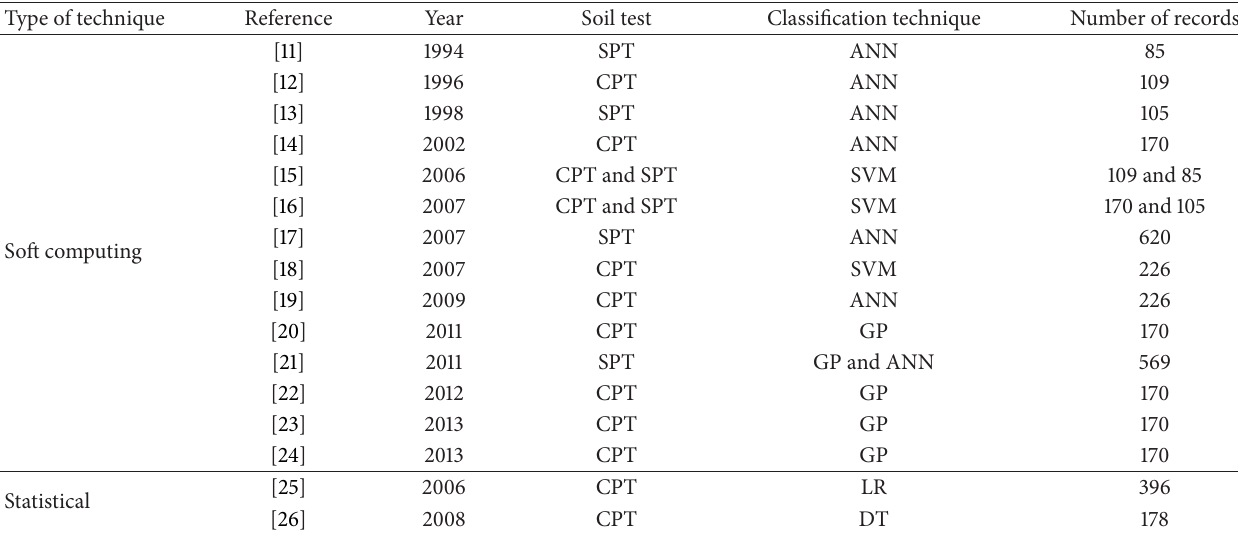
Table 1: Different liquefaction models proposed in the